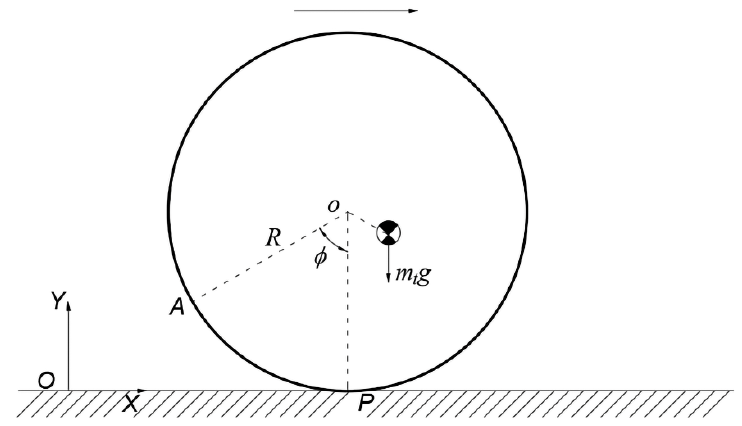
Figure 9. Equivalent rolling motion.